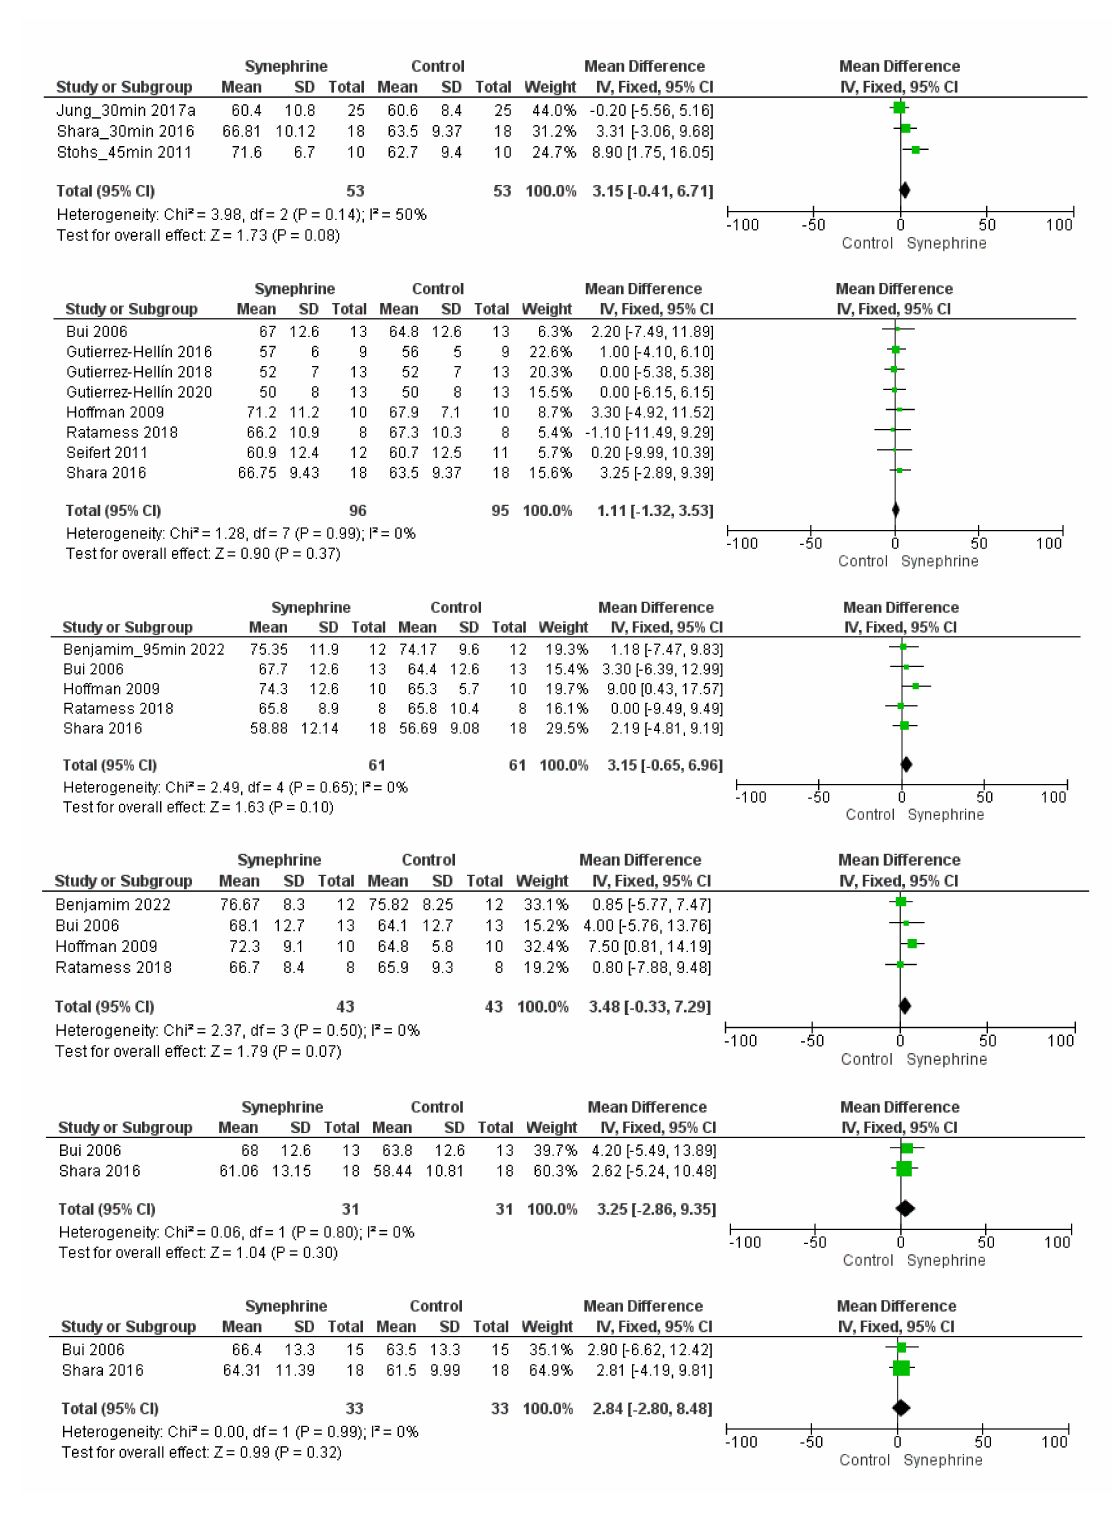
Figure 5. Forest plot diagram of synephrine on heart rate acutely (after 30–45 min; 1 h; 2 h; 3 h; 4 h; and 6 h) in intervention and control